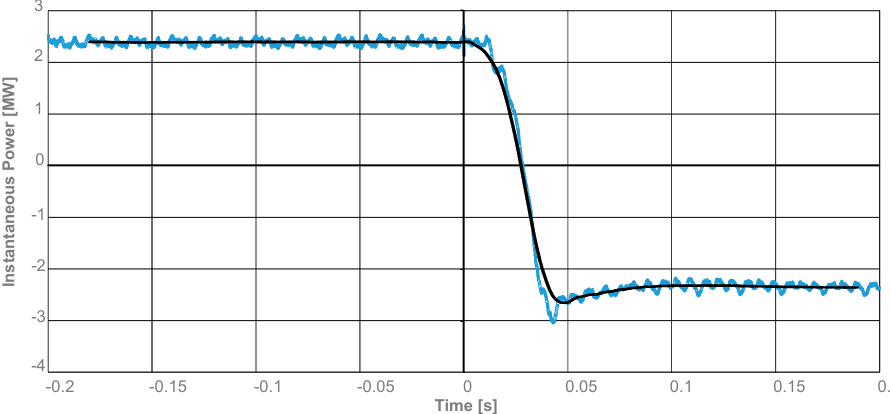
Figure 10. Rated discharge to rated charge power: active one ( dark line) and instantaneous one ( azure line).